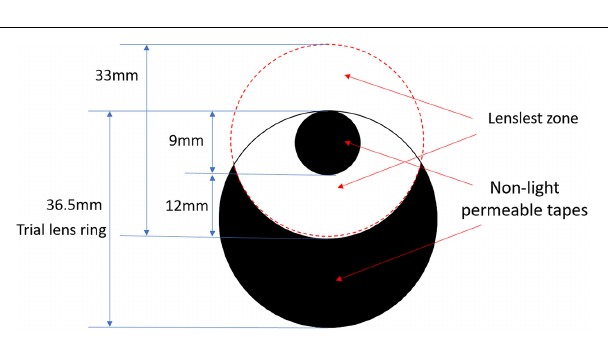
FIGURE 2 | Pictorial representation of patched lenses. The large solid circle of 36.5-mm diameter represents the actual edged lens (trial lens). The small black circle of 9-mm diameter represents the patched central clear zone of the original lens, and the black crescent-shaped area represents the patched peripheral clear zone of the original lens. All four lenses were patched in identical